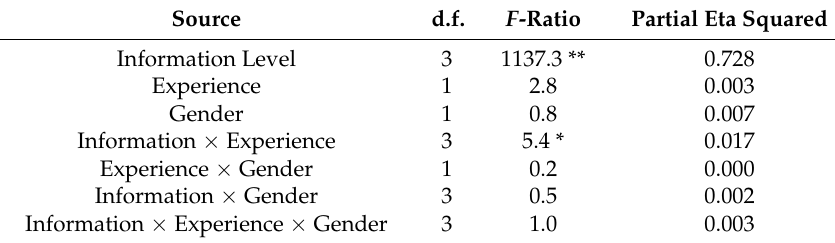
Table 5. Analysis of variance results for subjective workload